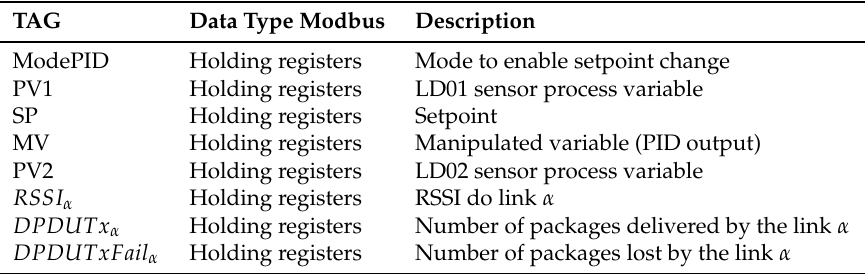
Table 3. Controller Modbus memory